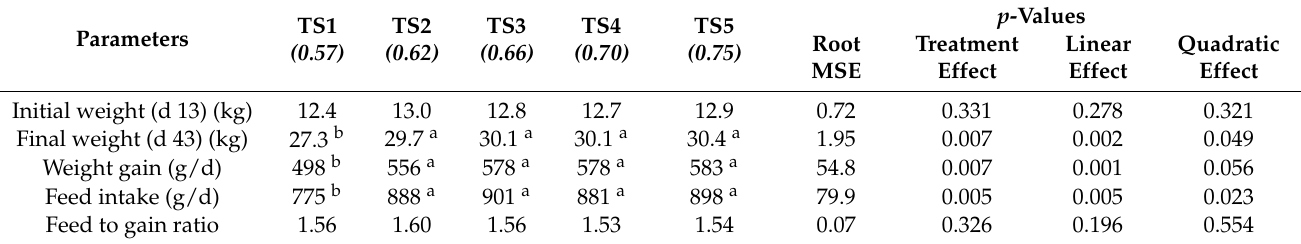
Table 6. Performance parameters of piglets between day 13–43 of trial (starter